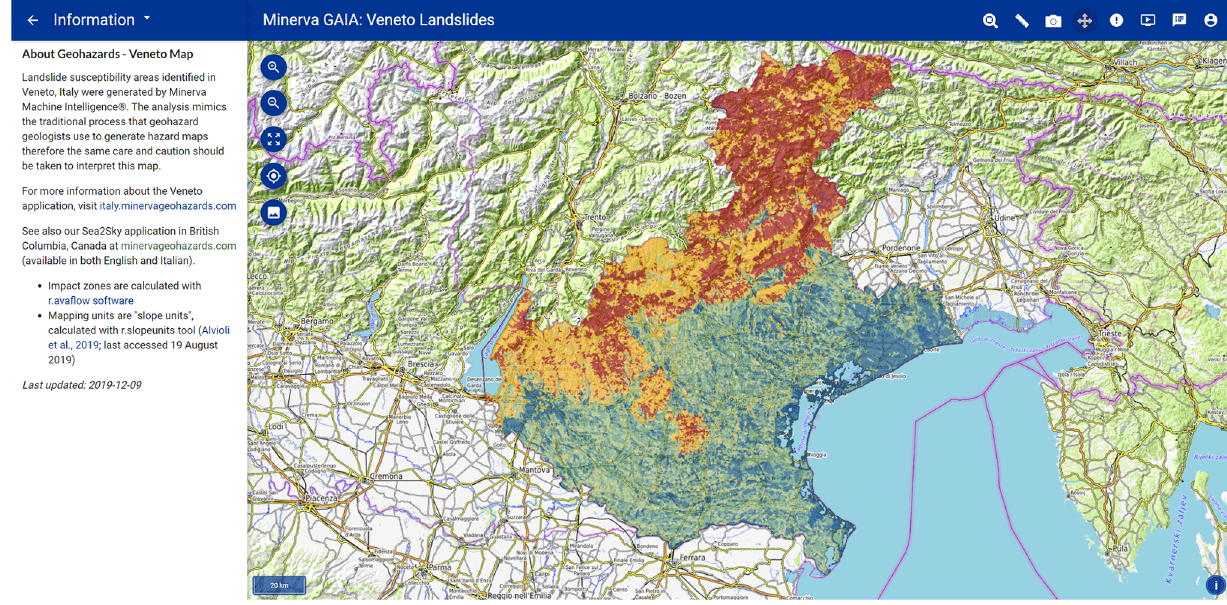
Figure 6. Web map interface showing susceptibility to slides in soil in Veneto, Italy. Colours range from blue (0–20 score percentile) to dark green (20–40 score percentile), light green (40–60 score percentile), yellow (60–80 score percentile), red (80–99.9 score percentile), and